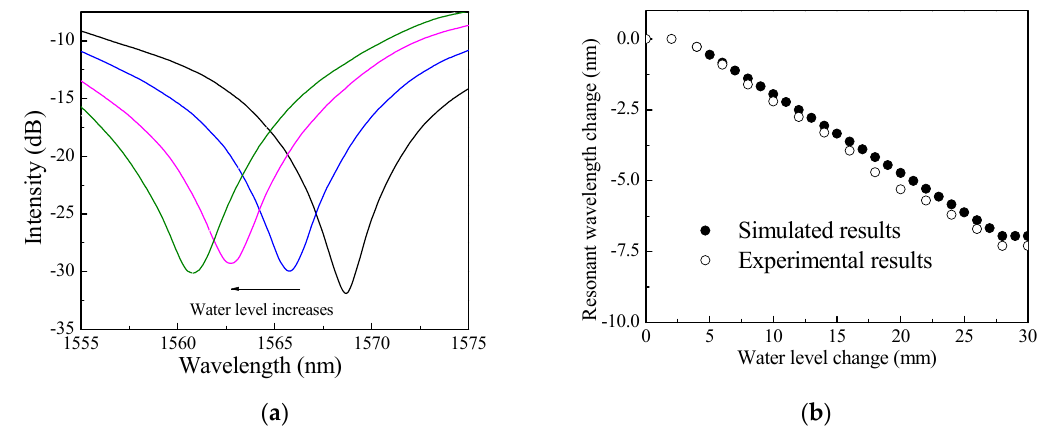
Figure 4. ( a ) Transmission spectrum; ( b ) Resonant wavelength changes of LP 07 to water level changes.